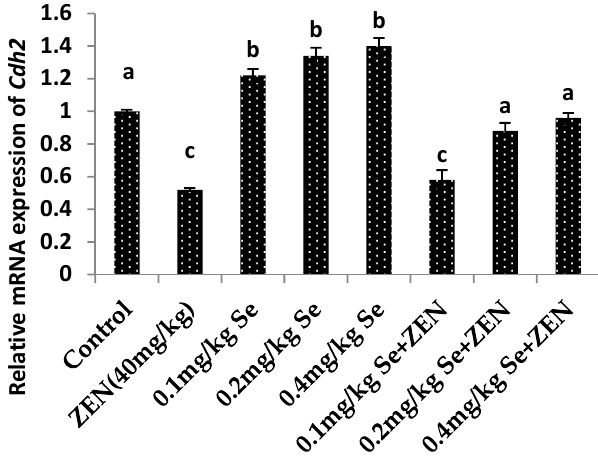
Figure 6. Effect of ZEN, different concentration of selenium yeast and their co-treatment on the relative mRNA expression of Cdh2 in mice testicular tissue. Values are mean ± SE of twenty mice in each group. a–c Means with different letters are significantly different, p < 0.05. a p < 0.05 vs. ZEN-treated group, b p < 0.05 vs. control group and ZEN-treated group, c p < 0.05 vs. control group.